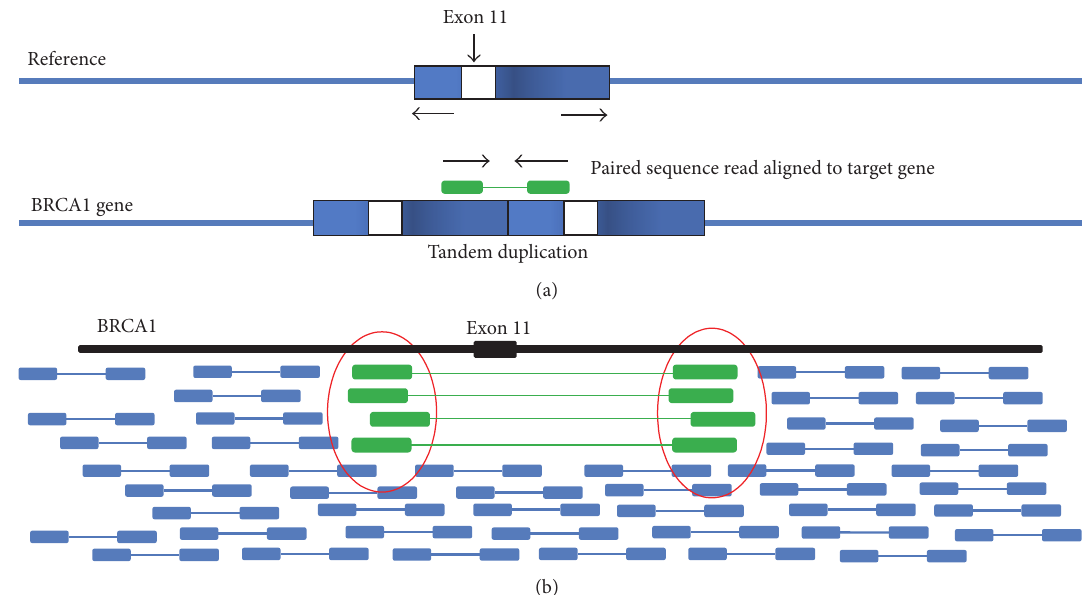
Figure 3: Identification of tandem duplication insertion breakpoints spanning BRCA1 exon 11, using paired-end sequencing. (a) Mapped read pairs in the wrong orientation indicate a tandem duplication. (b) Ambry’s breakpoint detection tools can identify clusters of read pairs with soft clipping which indicate rearrangement